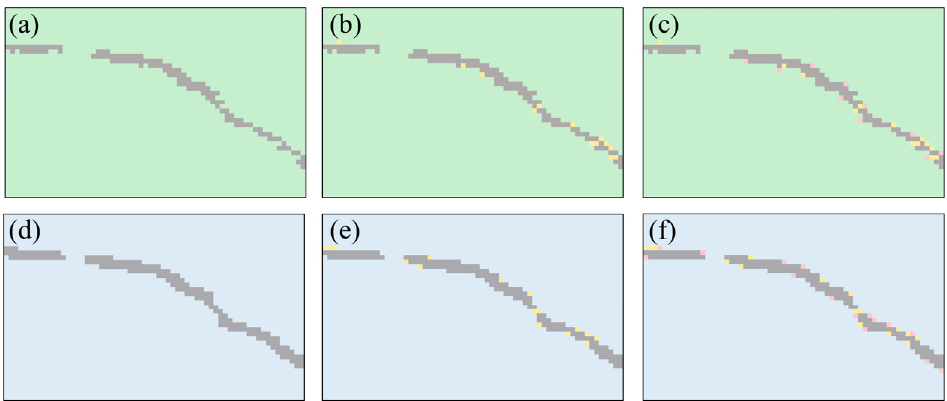
Figure 3. Raman spectral intensity mapping of the E 1 added yellow and red areas indicate the situation when the E 1 below ( a , d ) 68%, ( b , e ) 70% and ( c , f ) 72% of the monolayer signal, respectively.